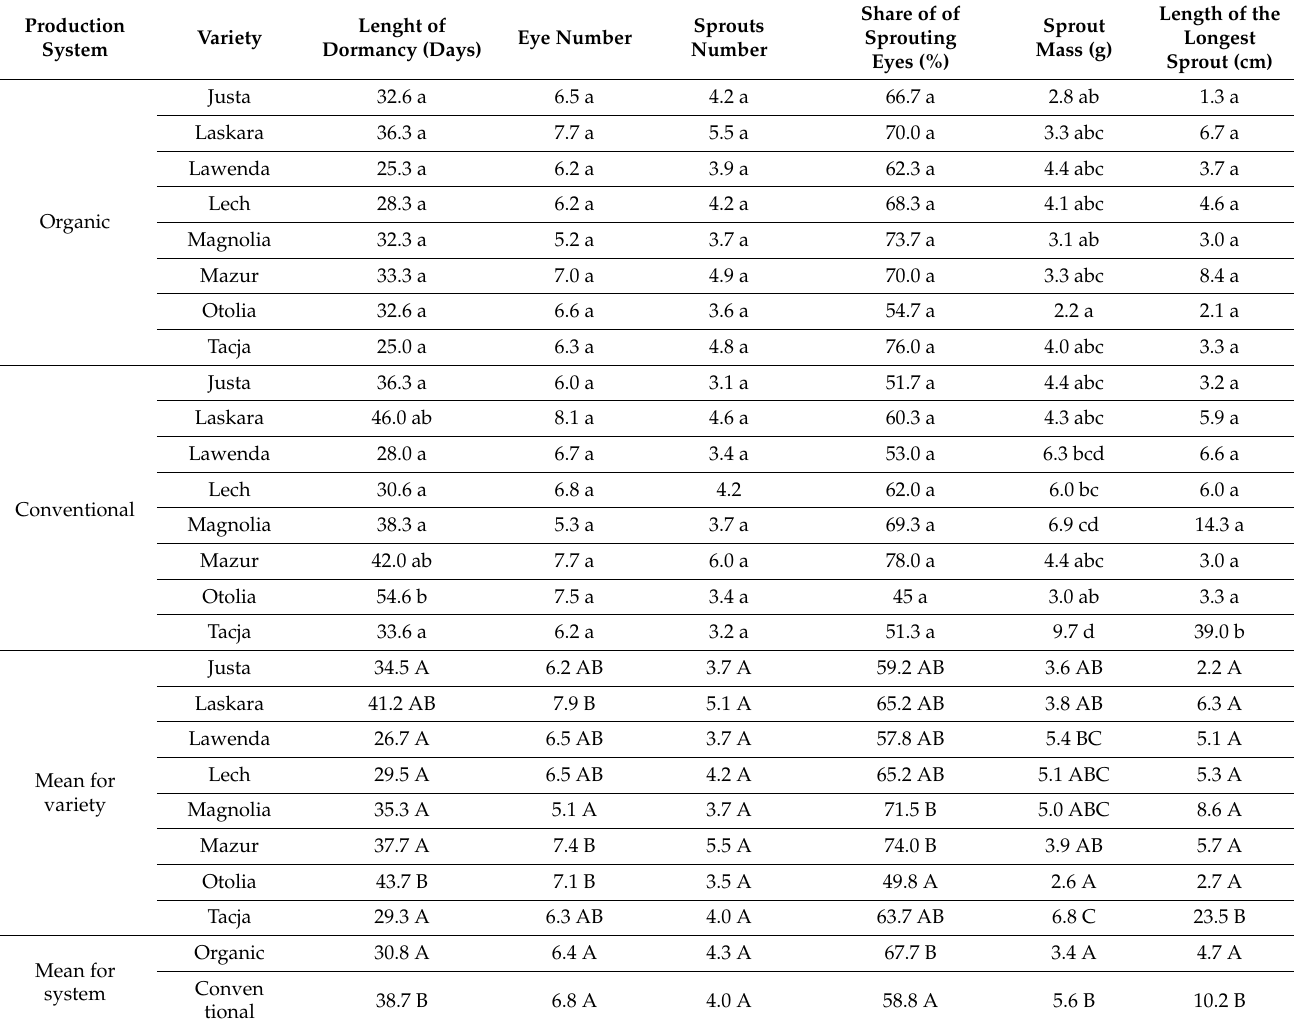
Table 5. The value of parameters characterizing tuber features in relation to variety and production